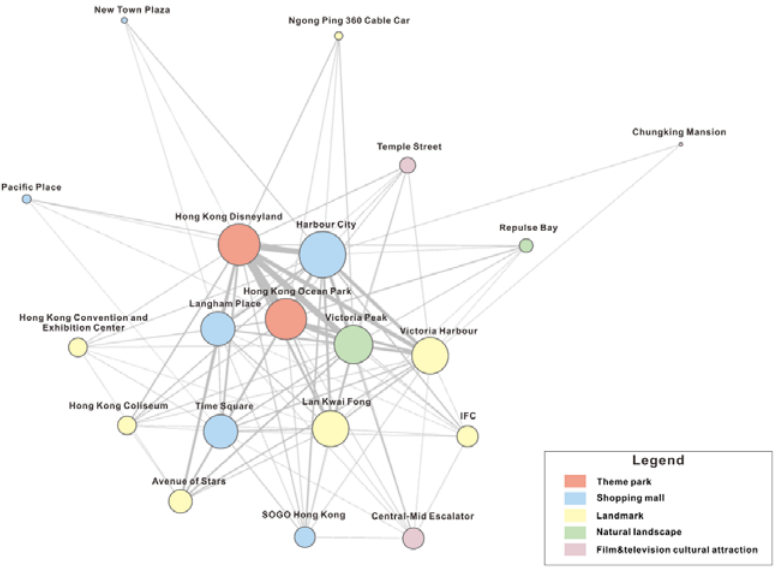
Figure 7. Force-directed graph of tourist attractions of class 2 visitors.